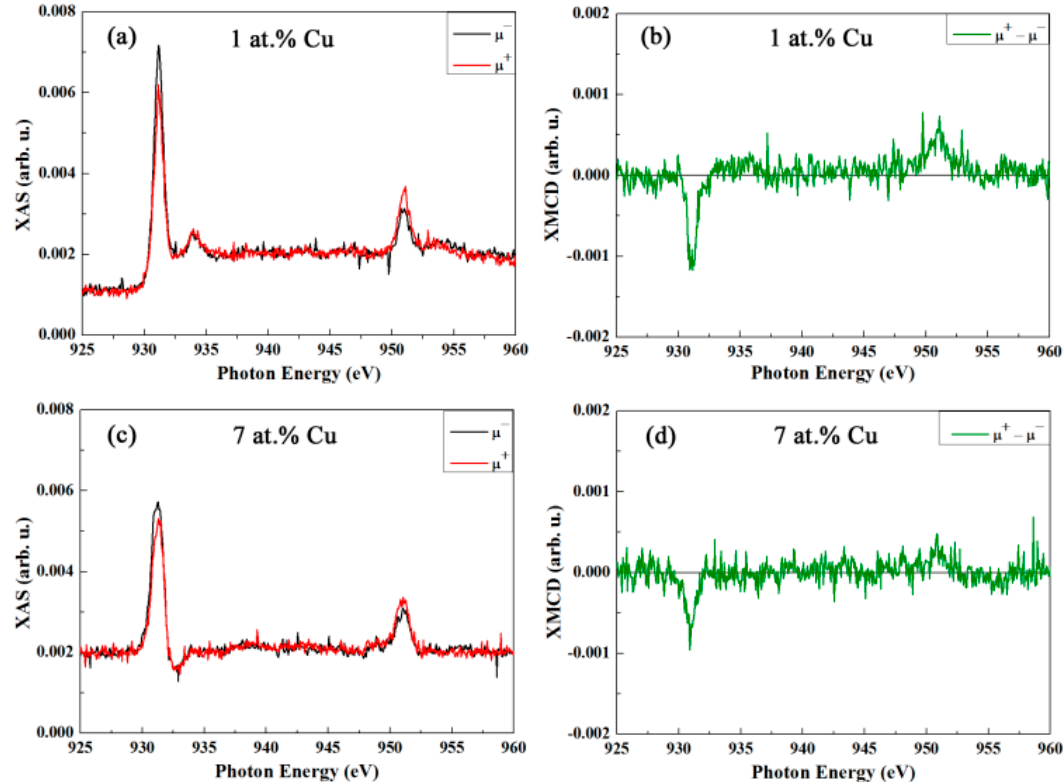
Figure 7. ( a , c ) Cu L 3,2 edge XAS spectra, measured in total electron yield mode for right ( µ + ) and left ( µ − ) circularly polarized light, recorded at 5 K (after cooling in 50 kOe) under an applied magnetic field of 50 kOe for the SnO 2 powders doped with ( a ) 1 at.% Cu and ( c ) 7 at.% Cu, respectively. ( b ) and ( d ) are the corresponding XMCD signals at 5 K (i.e., difference between right and left circularly polarized light) for the SnO 2 powders doped with 1 and 7 at.% Cu, respectively.